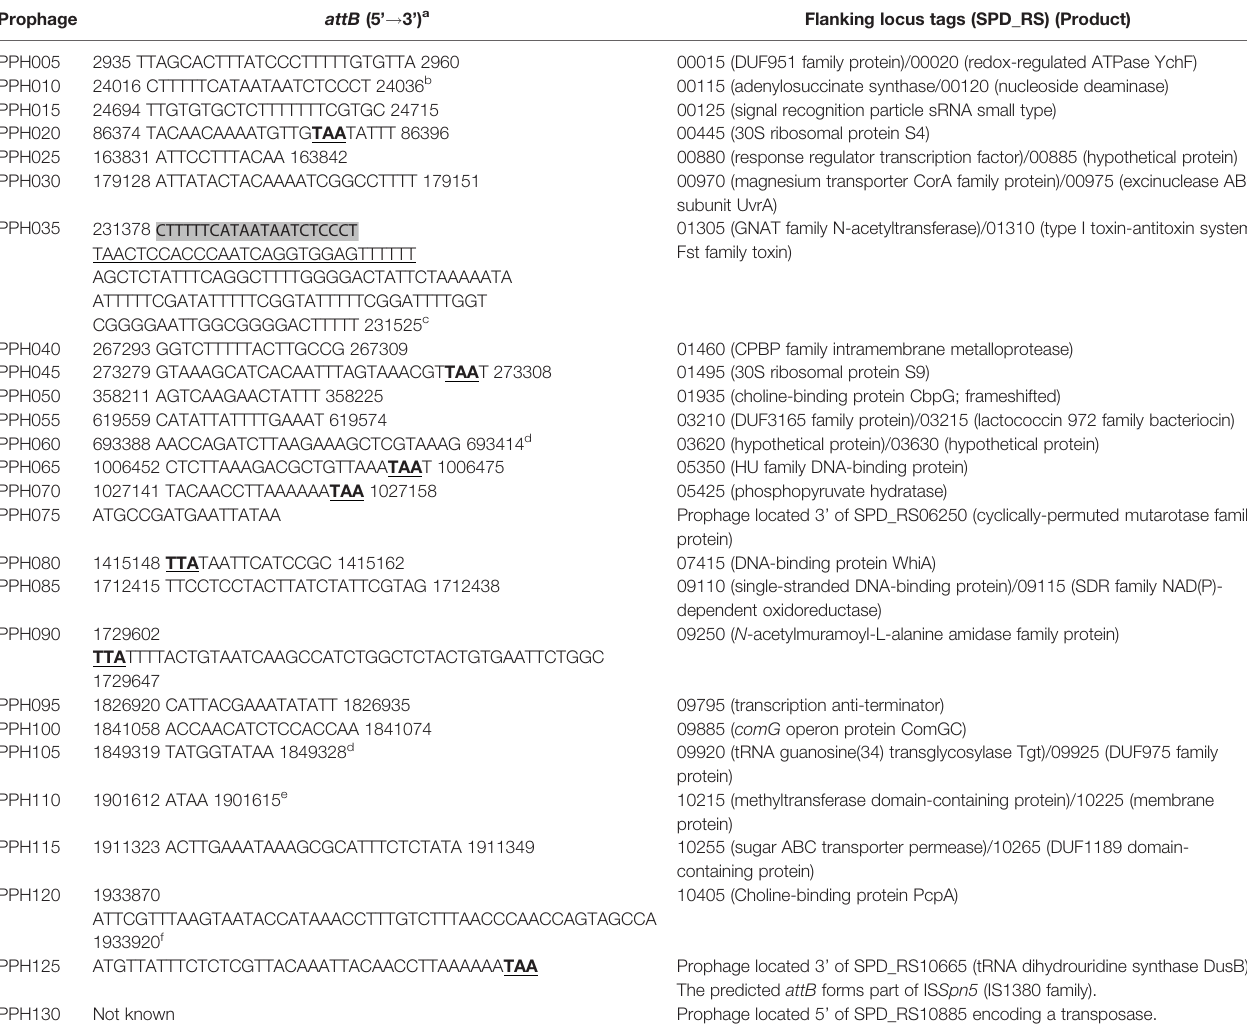
TABLE 4 | Localization of attB sites for S. pneumoniae temperate prophage integration. Prophage attB (5 ’ ! 3 ’ ) a Flanking locus tags (SPD_RS)